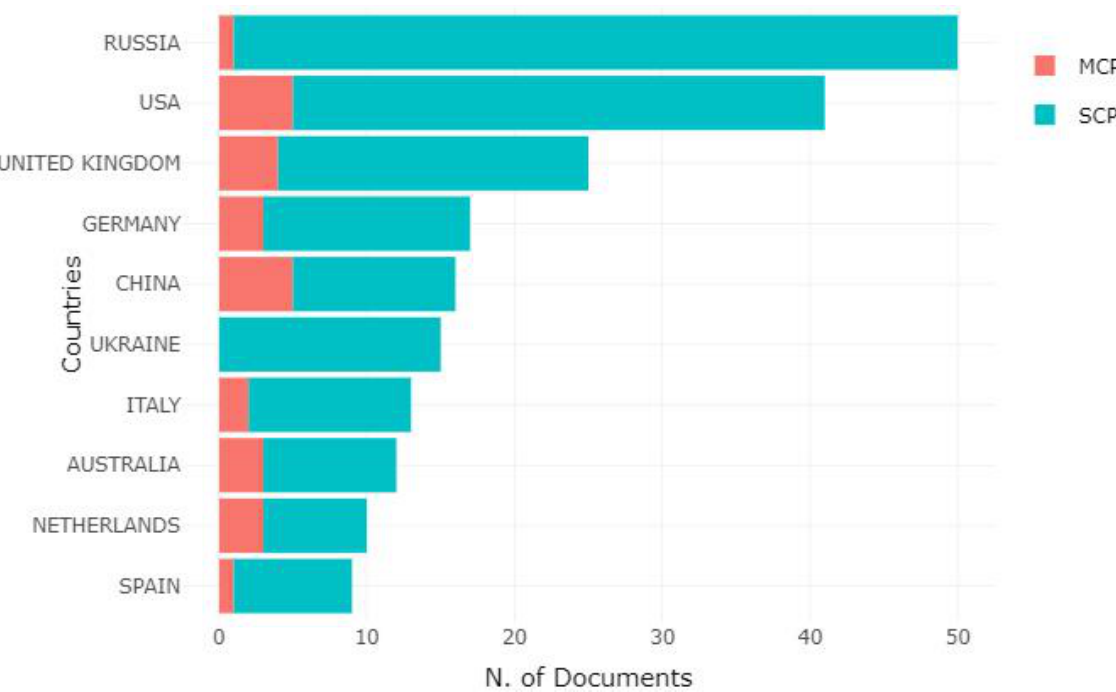
Figure 2. Corresponding author’s country. Intra-country (SCP) and inter-country (MCP) collaboration during 2015–2019. Table 8. The intra-country (SCP) and inter-country (MCP) collaboration indices during 2015–2019.